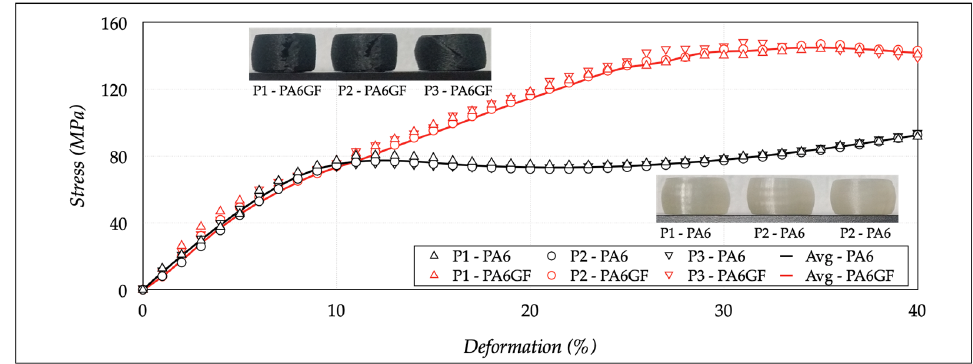
Figure 8. Compression tests for dry-as-mold specimens.